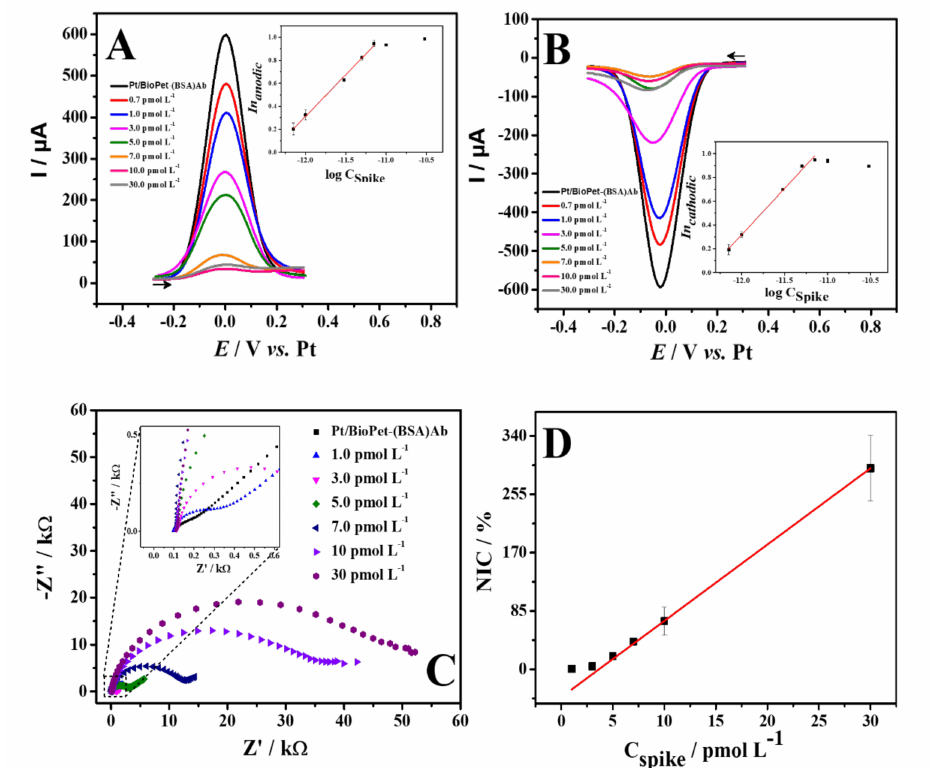
Figure 5. Square wave voltammograms direct ( A ) and reverse ( B ) obtained for different concen- trations of spike protein of 0.7 − 7.0 pmol L − 1 . Inset: Plot of peak current versus spike protein concentration of 0.7 − 7.0 pmol L − 1 . SWV experimental conditions: square wave amplitude: 80 mV; frequency: 80 Hz; step potential: 10 mV. ( C ) Nyquist plots obtained for different concentrations of spike protein of 1.0 − 30 pmol L − 1 . ( D ) Plot of spike protein concentrations versus NIC%.